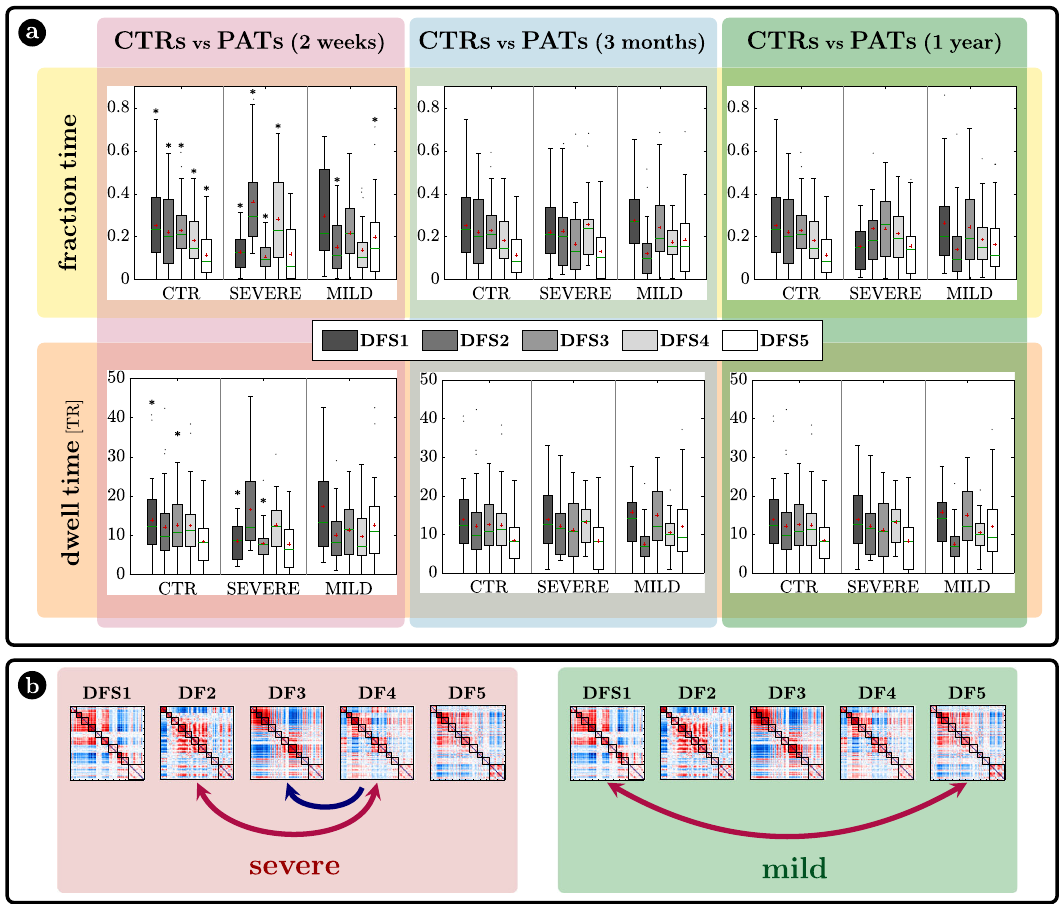
Fig. 5 | Results. a Fraction time and lifespan. This fi gure represents two dynamical measures related to the dynamic functional states (DFSs), namely the fraction time (top) and the average dwell time (bottom). Comparisons between healthy controls (CTRs) and stroke patients (PATs) at different conditions are represented. To be noticed: (i) fraction times and dwell times show similar patterns, but fraction times are more sensitive to identify group differences, and (ii) all dynamic impairments identi fi ed at the sub-acute stage, recovered in the chronic stage. The signi fi cance between each pair of groups has been tested independently for each of the 5 DFSs throughone-sidednon-parametricpermutationtests,andfalsediscoveryrate(FDR)